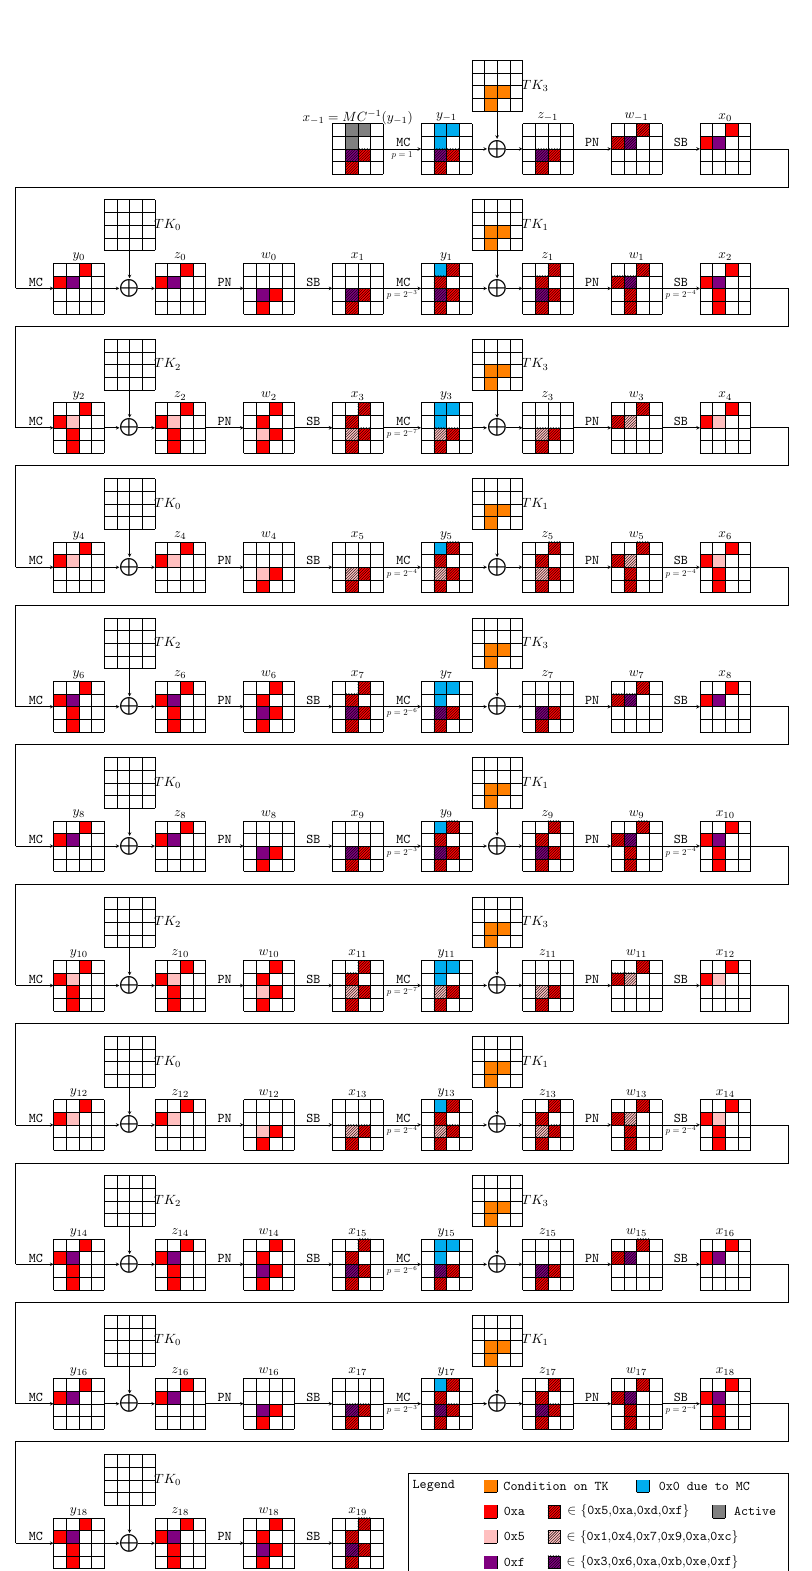
Figure 16: A 20-round weak-key truncated differential distinguisher of CRAFT with proba- bility 2 −